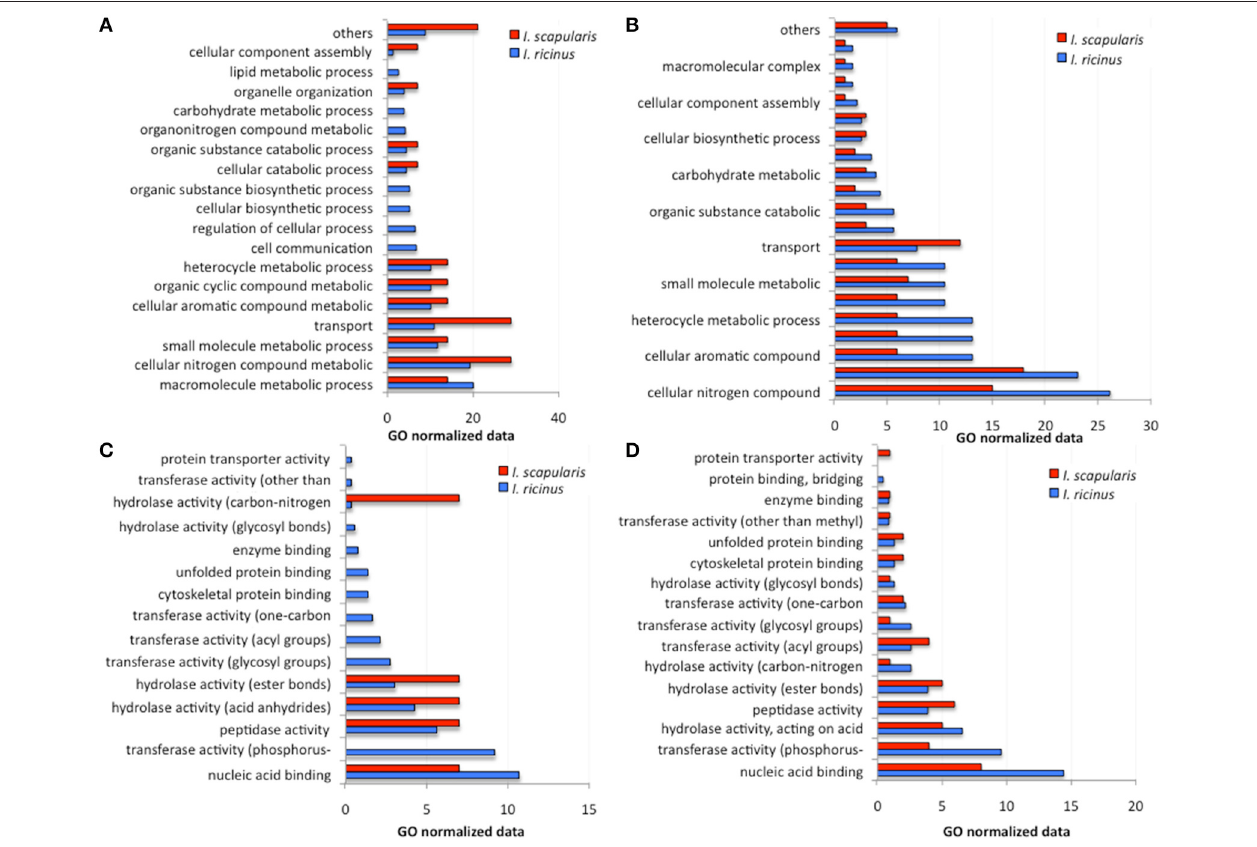
FIGURE 4 | GO normalized data for differentially expressed genes in response to A. phagocytophilum infection of I. ricinus IRE/CTVM20 and I. scapularis ISE6 cells. (A) BP for upregulated genes. (B) BP for downregulated genes. (C) MF for upregulated genes. (D) MF for downregulated genes. For all BP and MF categories in both upregulated and downregulated genes, values were compared between tick cell lines by Chi 2 test and resulted in significant differences at p < 0.01 for all except for MF of downregulated genes in which differences were not significant between both tick cell